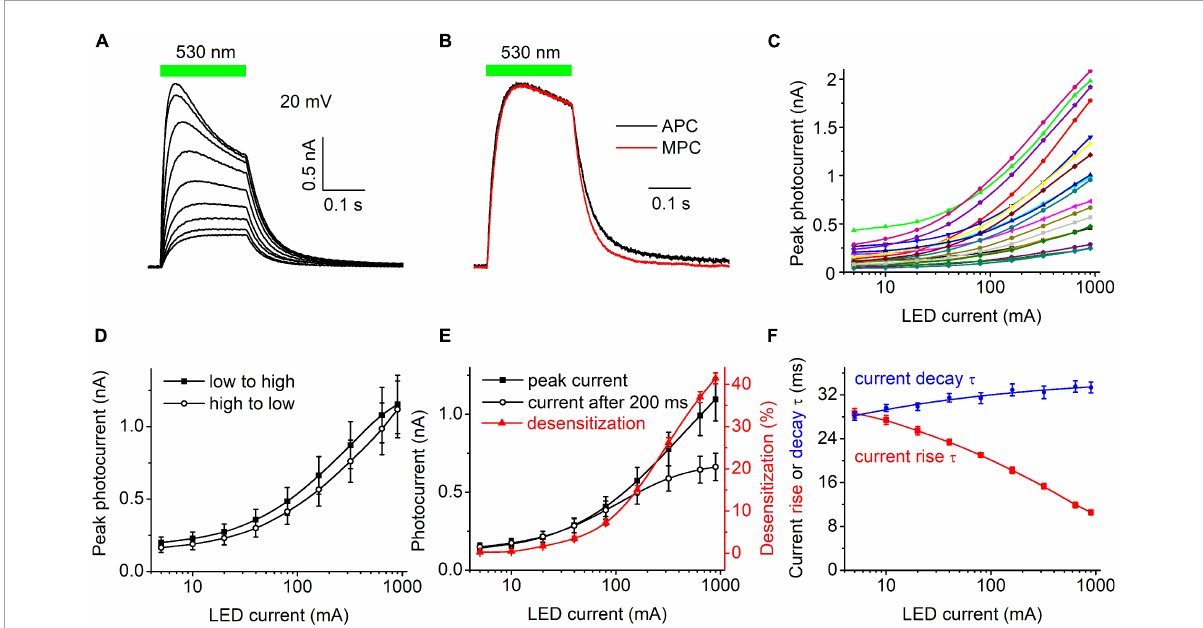
FIGURE1 (A) A series of photocurrent traces generated by Hc KCR1 at 20 mV in response to 200-ms light pulses of incremental intensity. The bar on top shows the duration of illumination. (B) Comparison of the normalized photocurrent traces recorded by automated patch clamp (APC, black) at 40 mA forward LED current and by manual patch clamp at 0.2 mW mm − 2 (MPC, red). (C) The dependence of the peak current amplitude on the light intensity (LED current) for 20 individual cells. (D) The mean curves for the responses measured upon variation of the LED current from low to high and from high to low values. (E) The mean curves for the peak current and desensitized current at the end of the 200-ms light pulse (black symbols and lines, left axis). The red symbols and line (right axis) show the degree of desensitization calculated as the difference between the peak current and the current at the end of 200-ms illumination divided by the peak current and multiplied by 100%. The data points in (C,E) are connected with spline lines. (F) The dependence of photocurrent rise τ (red) and the main (fast) decay τ (blue) on the light intensity. The data points for the rise τ are connected with a B-spline line; the data for the decay τ are approximated with a logistic